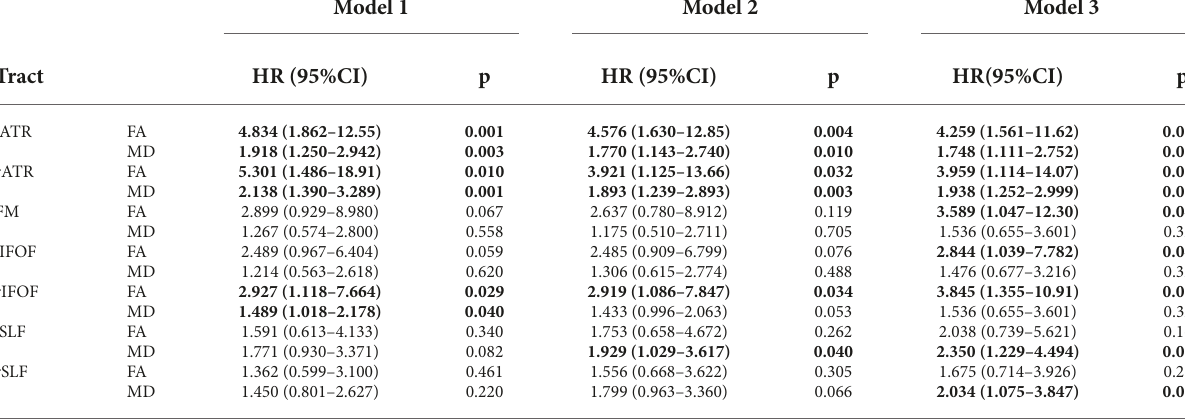
TABLE 3B Cox proportional hazard models of the DTI values for the incidence of frailty according to the KCL criteria ( n =